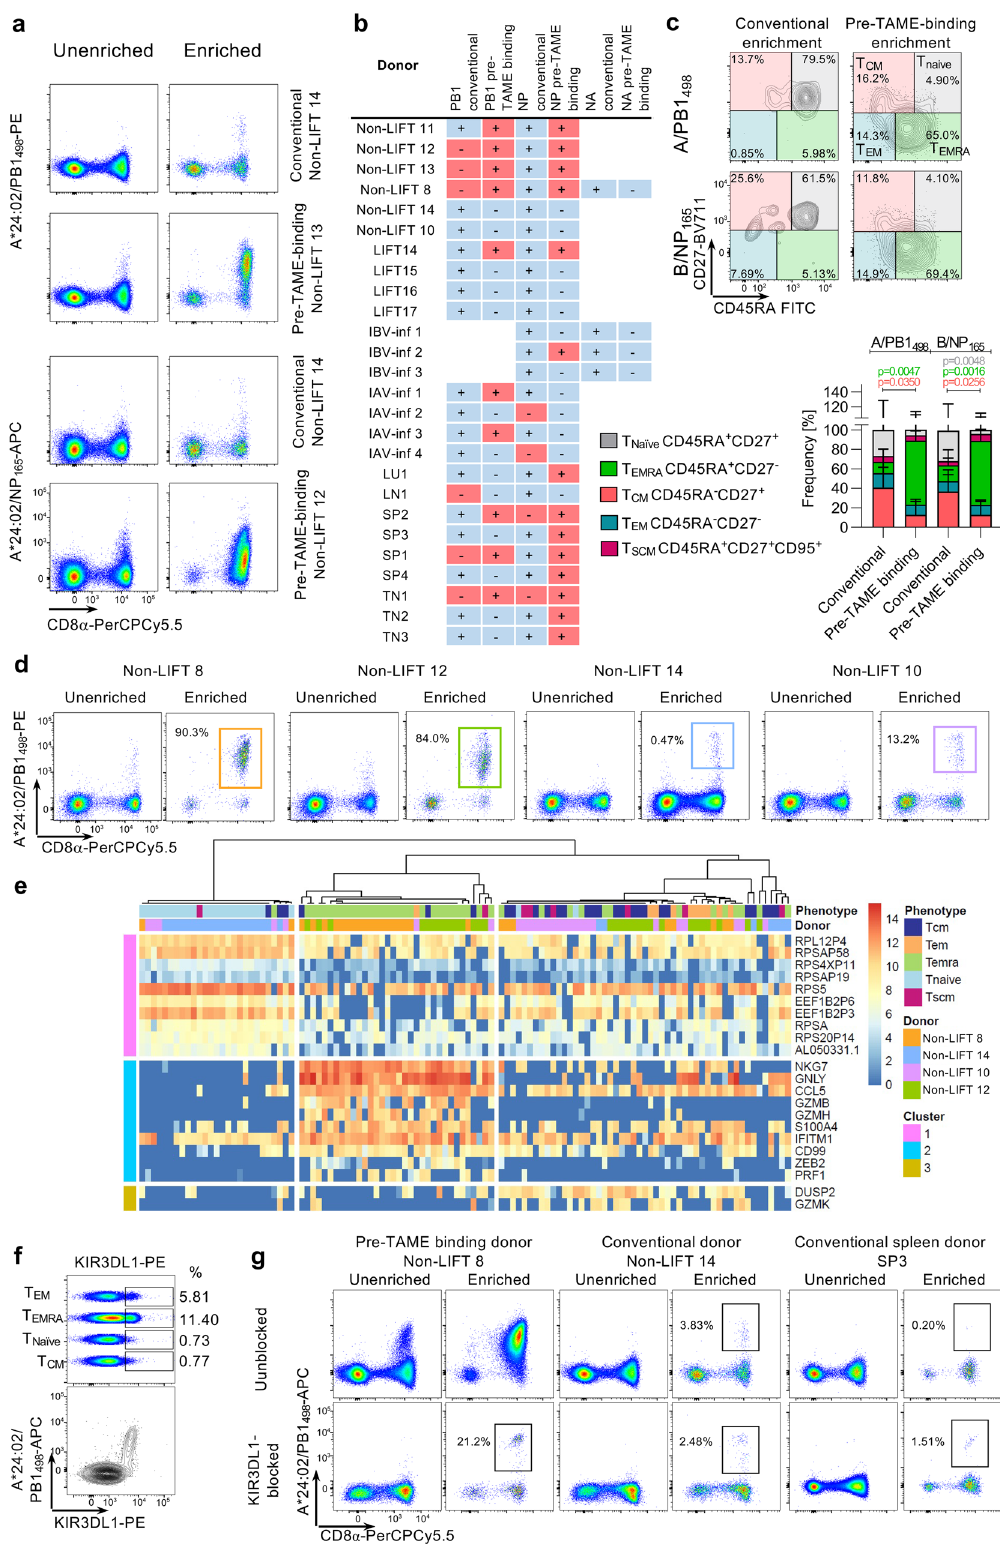
distinct characteristics of A/PB1 498 + CD8 + T EMRA cells within the two tetramer-binding populations. NKG7 (natural killer cell granule protein 7) and GNLY (granulysin) are key CD8 + T-cell effector genes 53 located on the same immunoregion locus containing all the natural killer-receptor